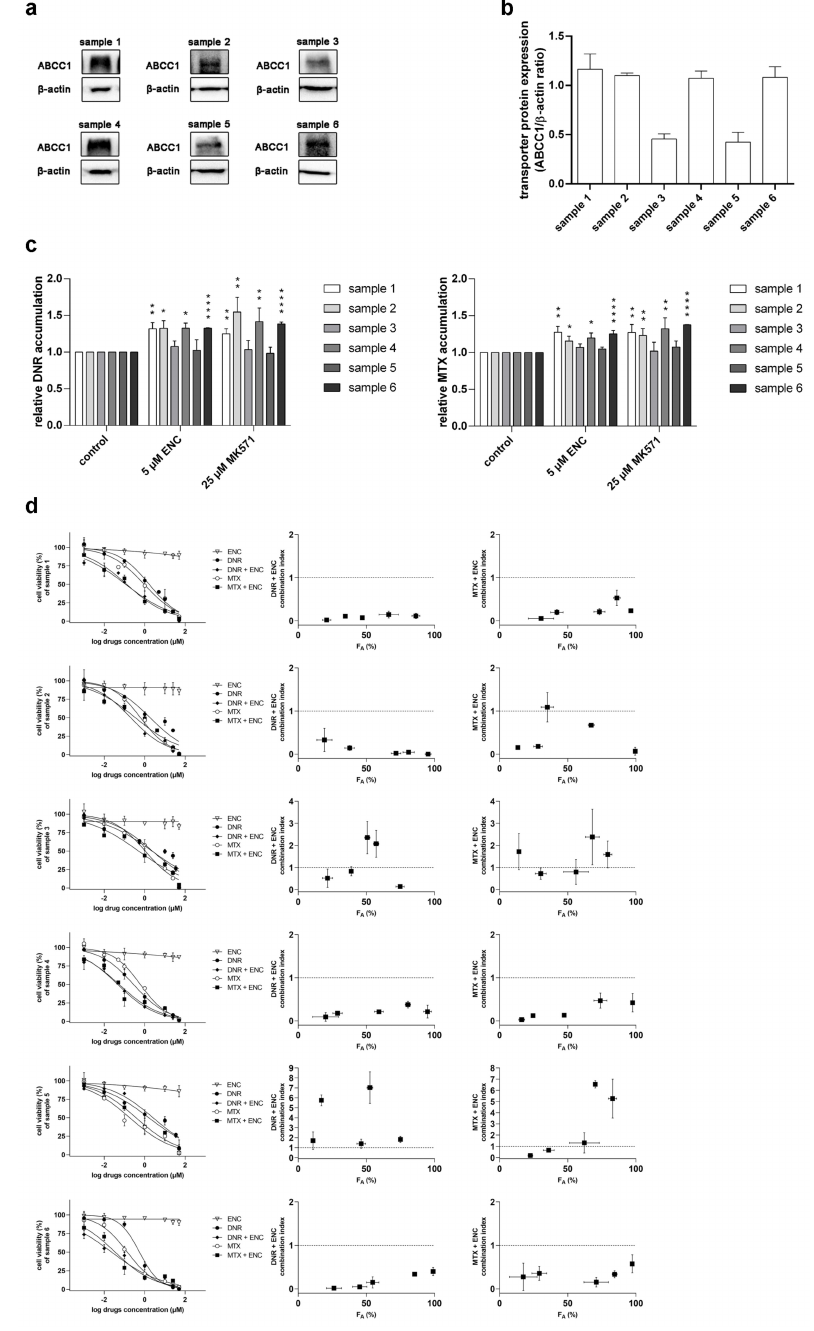
Figure 4. Encorafenib (10 µ M) attenuates the intrinsic drug resistance of ex vivo patient-derived NSCLC primary explants to cytostatic MDR victims (daunorubicin and mitoxantrone). First,